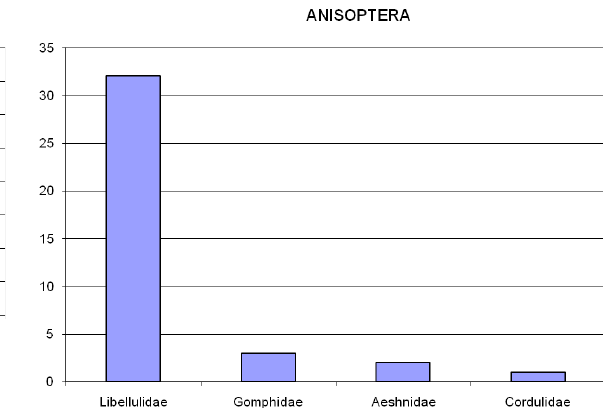
Figure 2. Family contribution under Sub-order Anisoptera to odonate diversity of Goa Except Aciagrion hisopa, Aciagrion pallidum, Agriocnemis lacteola, Enallagma parvum, Pseudagrion malabaricum, Ellatoneura tetrica and Lestes viridulus listed by Kulkarni & Talmale (2008) from the Fauna of